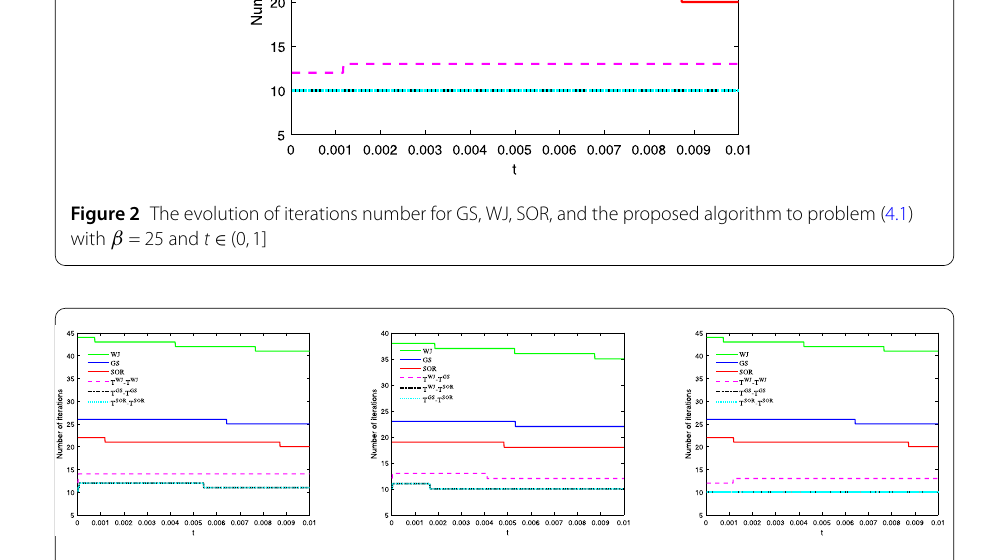
Figure 3 The evolution of iterations number for GS, WJ, SOR compared with the proposed algorithm using six cases of parameter ϑ n for problem (4.1) with β = 25 and t ∈